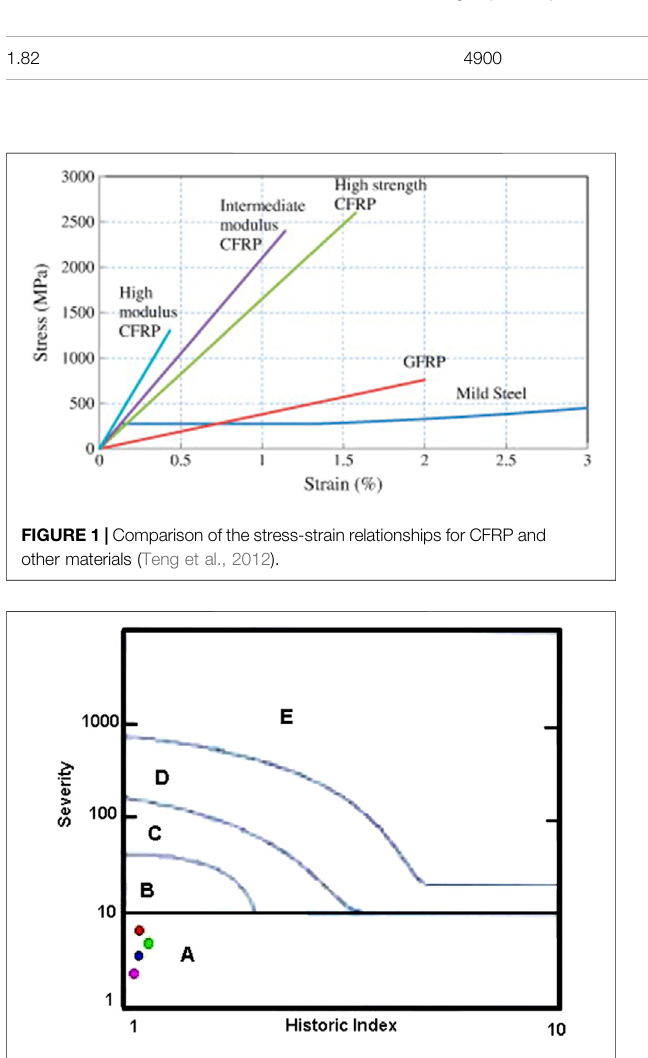
FIGURE 2 | Established intensity chart for the application of concrete (Golaski et al., 2002)